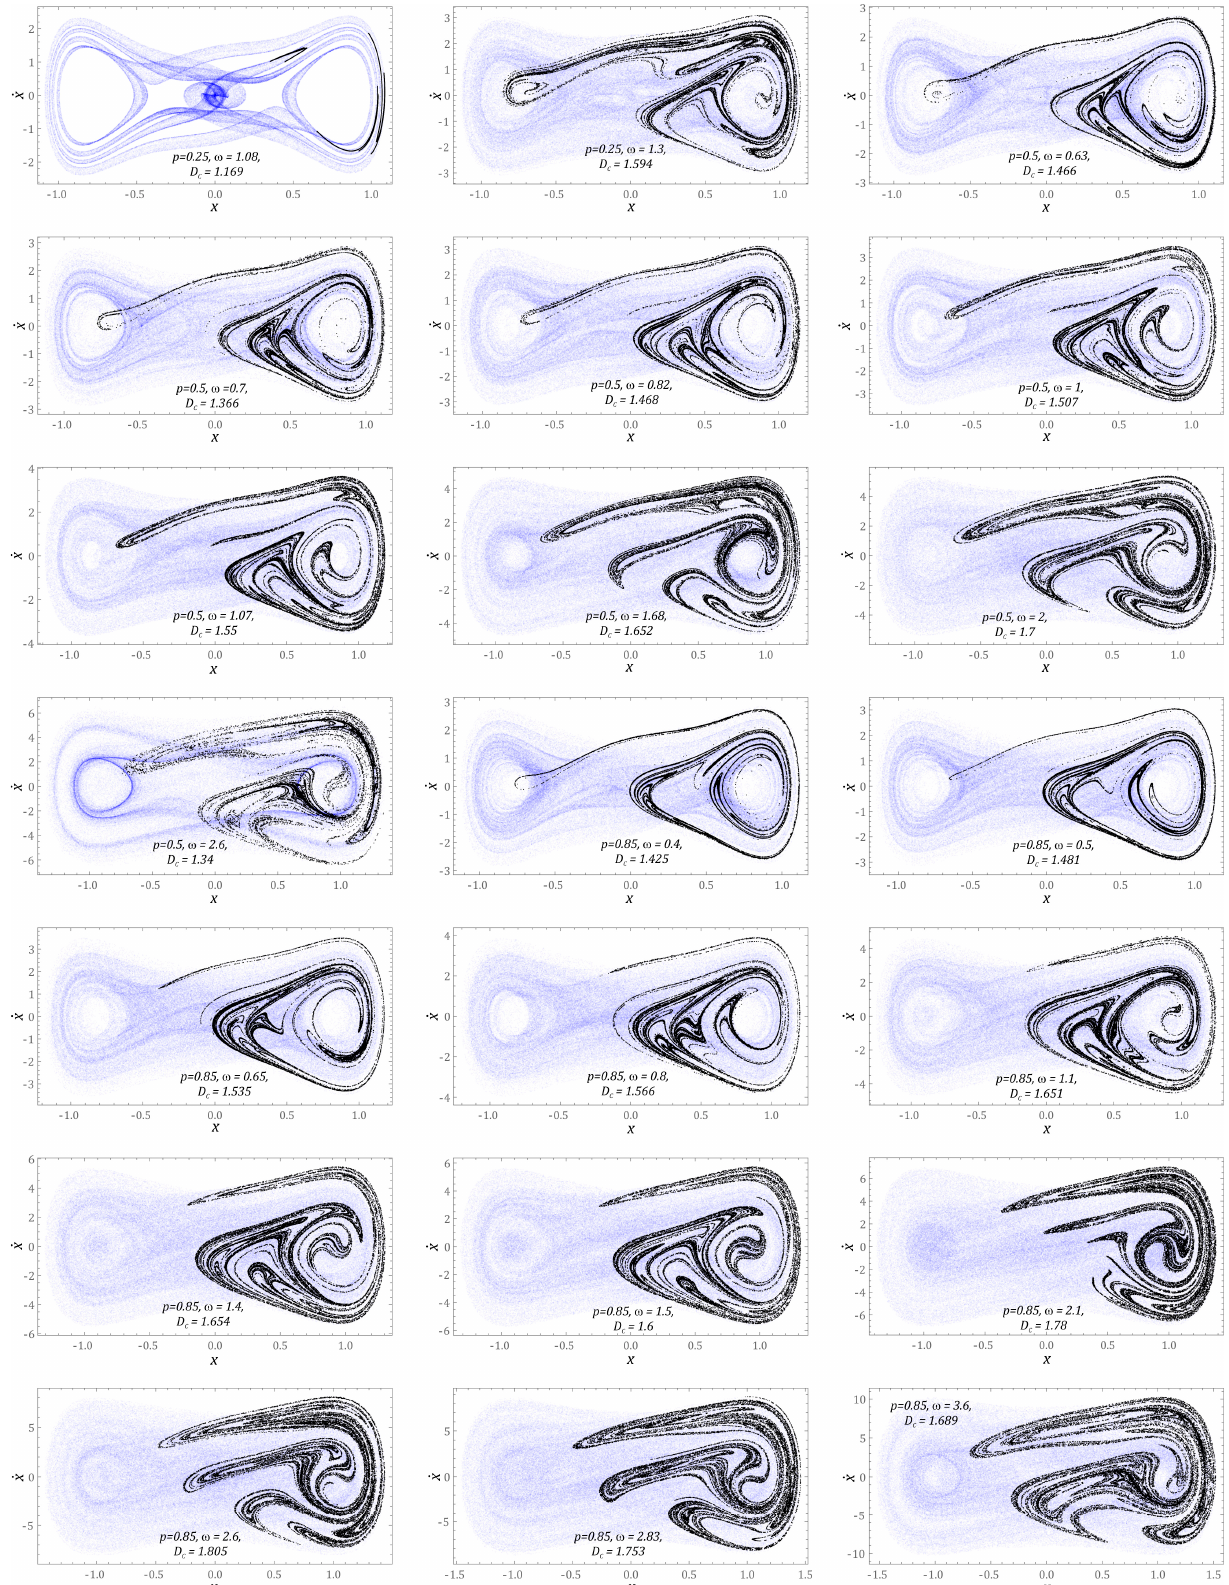
Figure 9. Example solutions showing geometric structures of chaotic phase flows and corresponding Poincare cross-sections, which were identified for a system with three potential wells (TEH). Dc denotes the corresponding correlation dimension. ω , p , x, and 𝑥(cid:4662) are dimensionless.